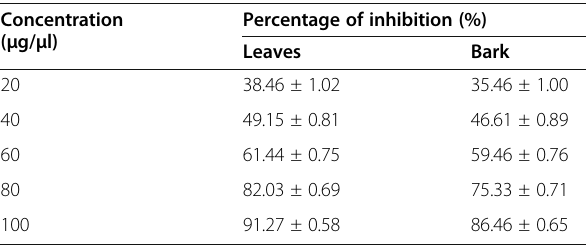
biologically active secondary metabolites, including es-